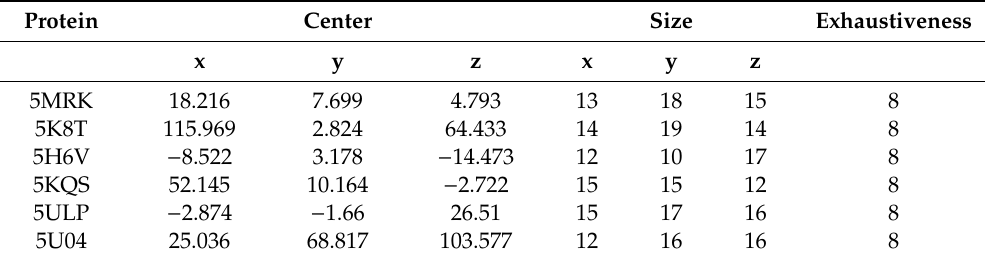
Key: methyltransferases (5MRK, 5KQS, and 5ULP), NS3 helicase (5K8T), protease (5H6V), NS5 RNA-dependent RNA polymerase